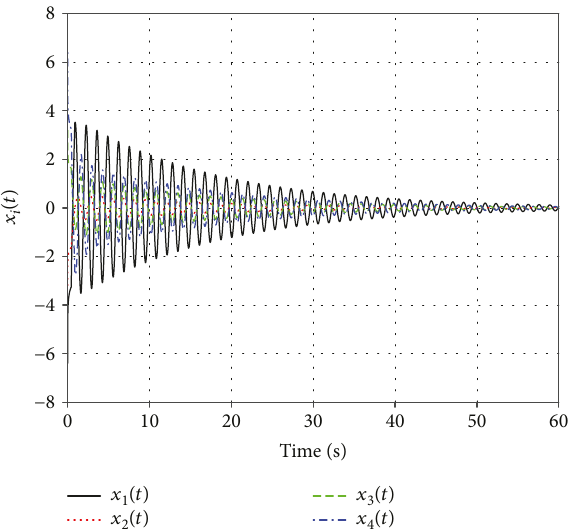
t applying the protocol in (7) under i . 2